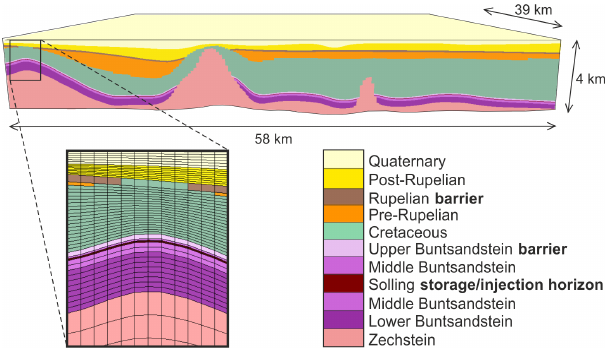
Figure 2. Perspective view of the 3-D geological model zoomed in on the anticlinal structure showing the mesh of the 3-D volume model. Vertical exaggeration is 2 :